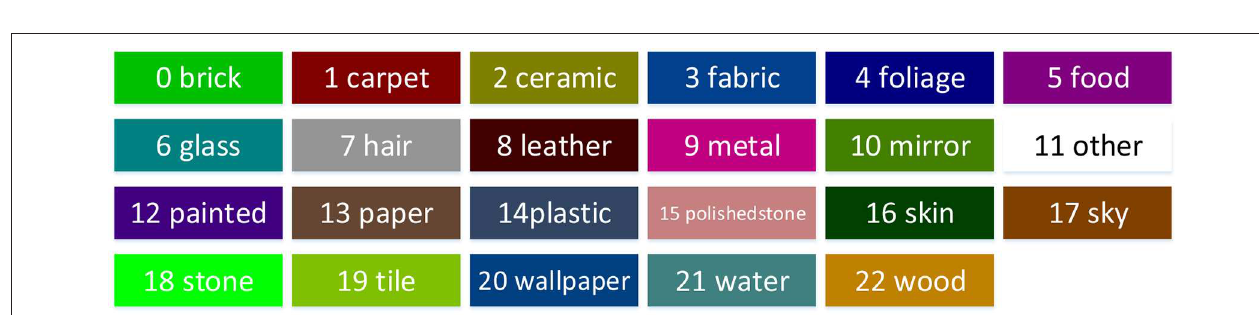
FIGURE 1 | The pipeline of the proposed system of simultaneous material segmentation and reconstruction.